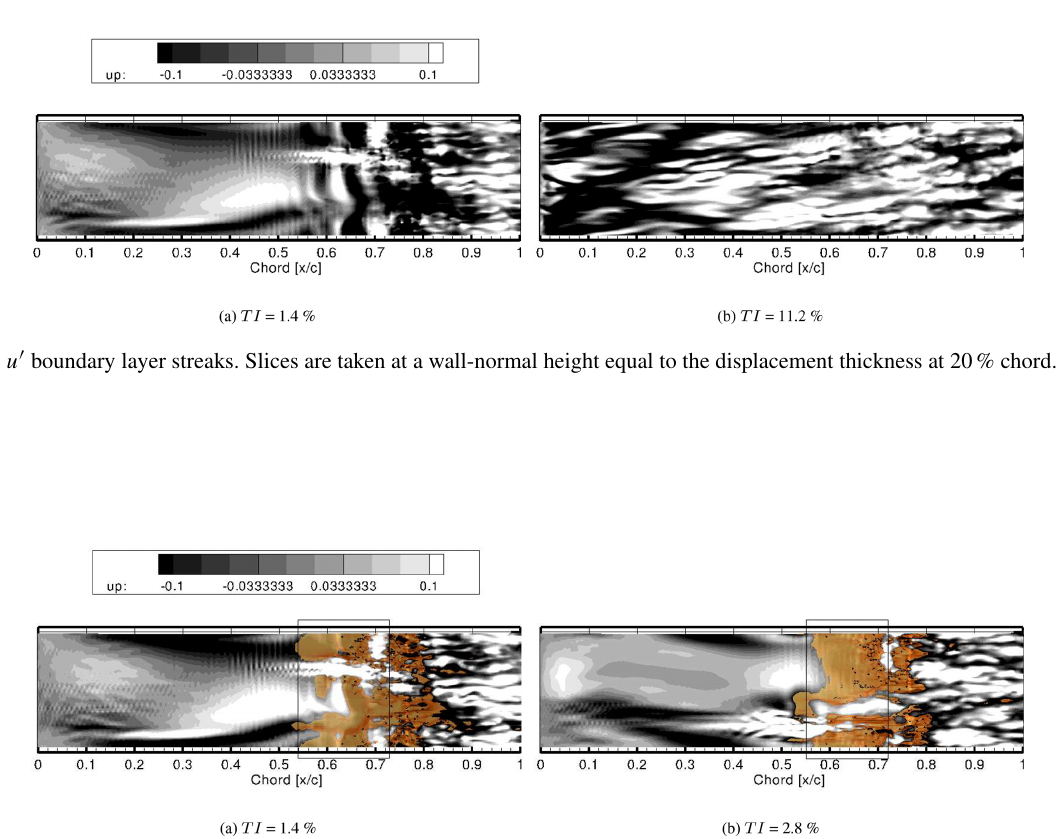
Figure 14. Influence of boundary layer streaks on instantaneous separation. The light and dark streaks represent high- and low-speed streaks, respectively. The orange iso-surface represents instantaneous separation. Slices are taken at a wall-normal distance corresponding to the displacement thickness at 20%